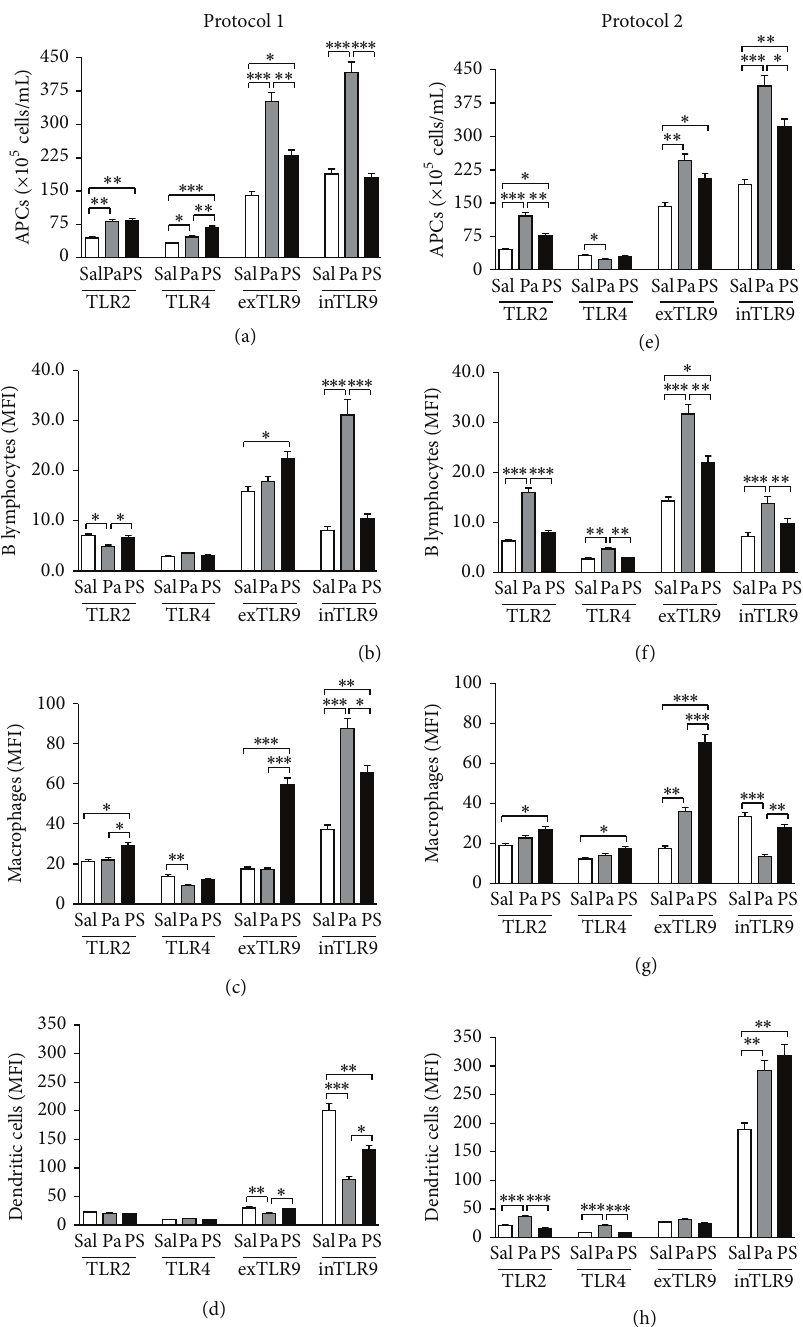
Figure 3: Expression of toll-like receptors by spleen antigen-presenting cells. Spleen cells from mice treated with saline (Sal), P. acnes (Pa), or PSwereobtained14daysafterHEWimplantationandstainedwithfluorochrome-conjugatedmonoclonalanti-mouseantibodiestodetermine the expression of TLR2, TLR4, and intra- and extracellular TLR9 by B lymphocytes, macrophages, and dendritic cells. Percentages obtained by flow cytometric analysis were converted to absolute numbers of B lymphocytes, macrophages, and dendritic cells positive for each receptor, which were added to obtain the total number of spleen APCs positive for such receptor in Protocols 1 (a) and 2 (e). Expression levels were also determined by mean fluorescence intensity (MFI) and individually analyzed in B lymphocytes ((b) and (f)), macrophages ((c) and (g)), and dendritic cells ((d) and (h)) for Protocols 1 and 2, respectively. ∗ 𝑃 < 0.05 ; ∗∗ 𝑃 < 0.01 ; ∗∗∗ 𝑃 < 0.0001